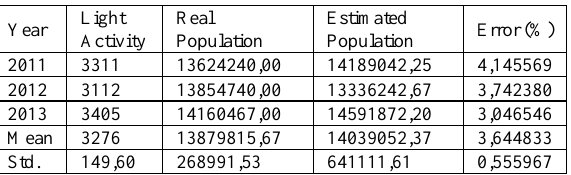
Table 4. Estimated population and error for Istanbul at 2011, 2012 and